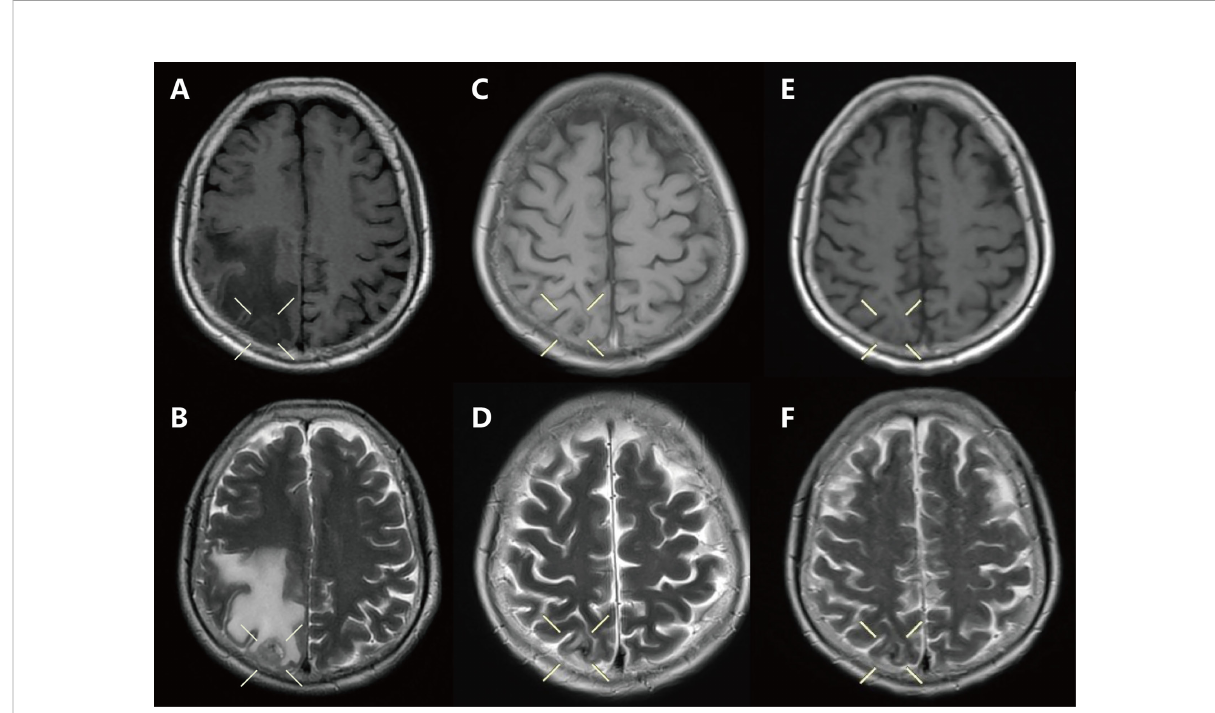
FIGURE 1 Craniocerebral magnetic resonance imaging of the brain showed: (A, B) Baseline: craniocerebral lesion before treatment. (C, D) Two months: after brain radiotherapy combined with osimertinib. (E, F) Seven months: after the use of erlotinib combined with